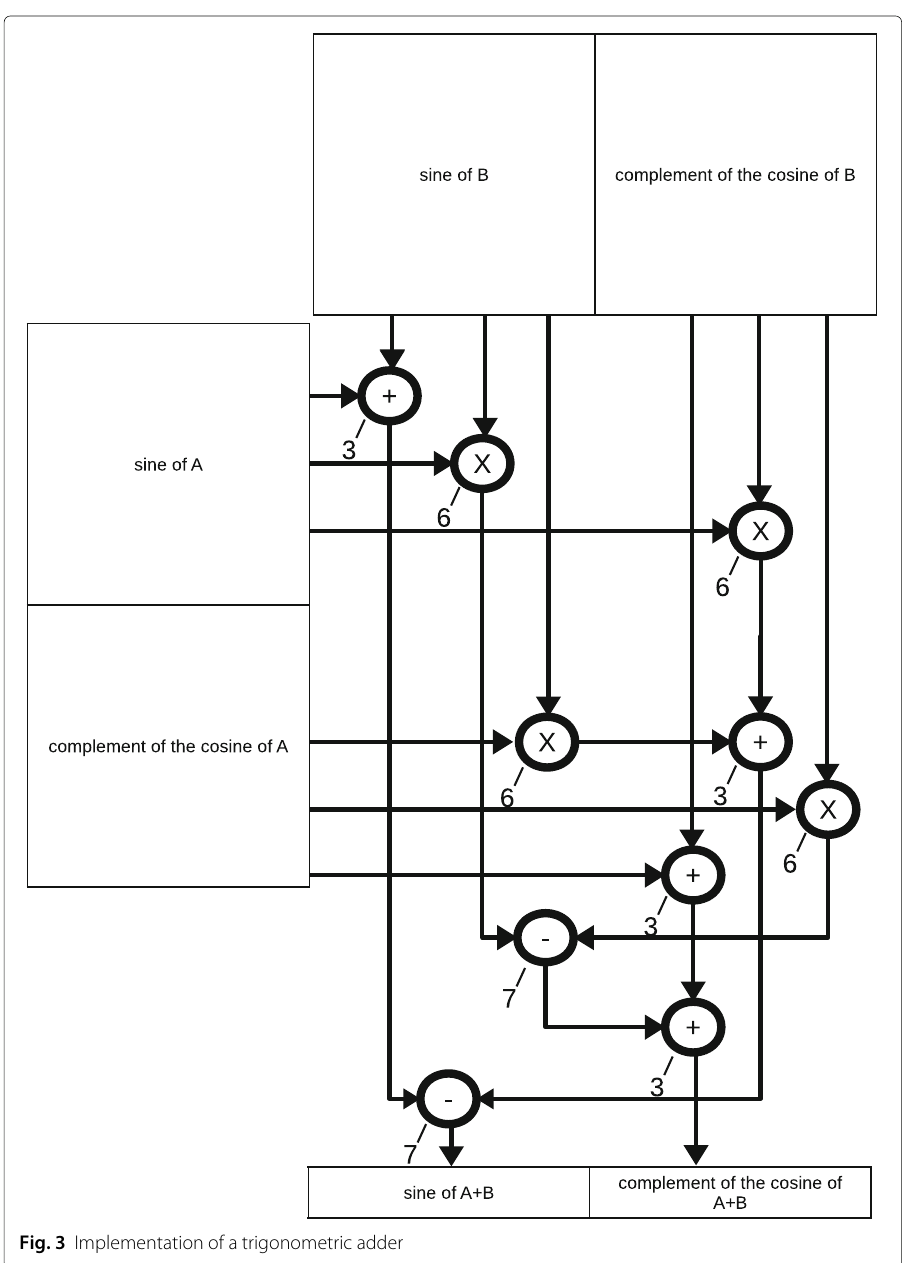
Fig. 3 Implementation of a trigonometric